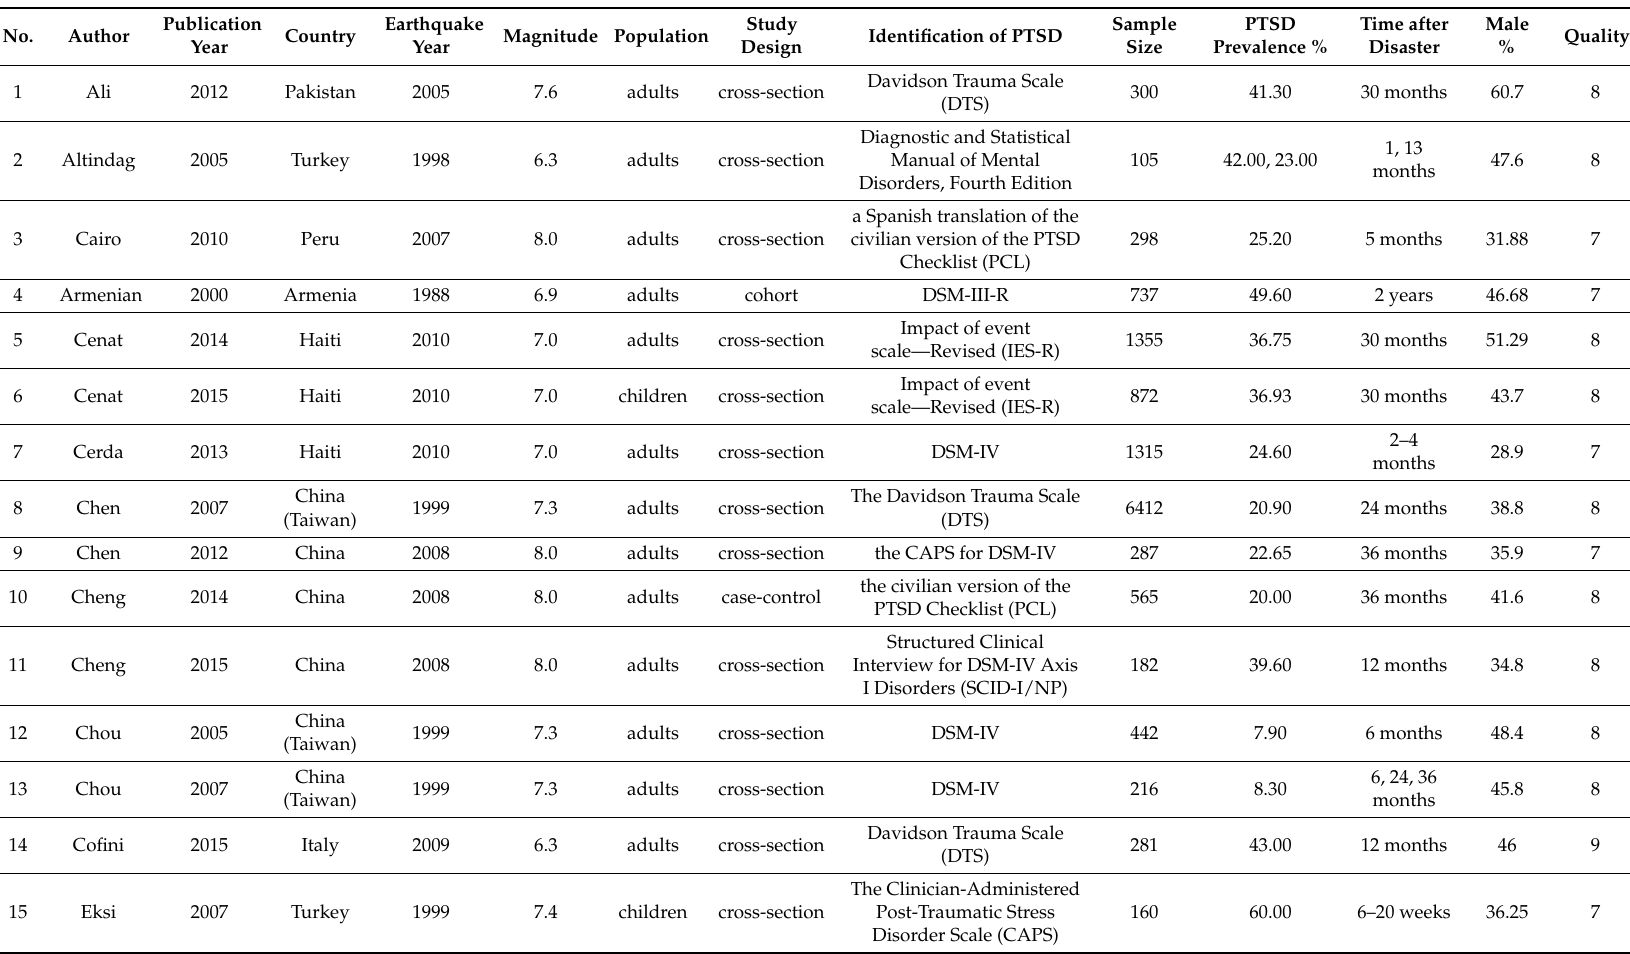
Table A1. General characteristic of the included studies with regard to risk factors for PTSD after